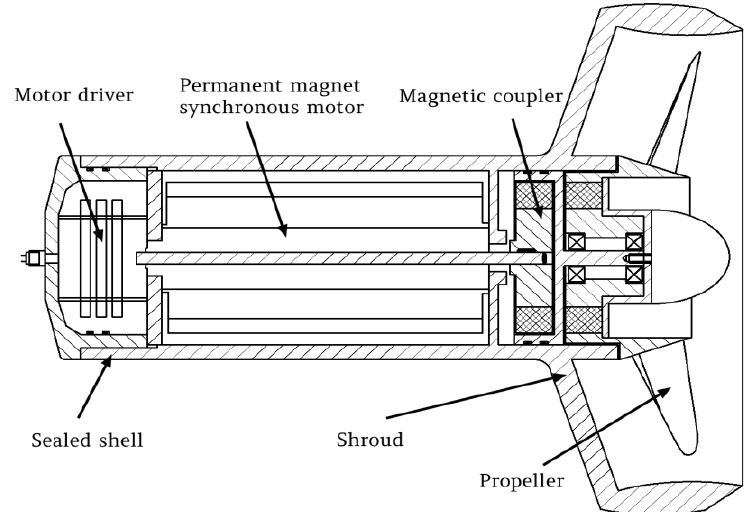
Figure 1. Magnetically coupled underwater thruster.